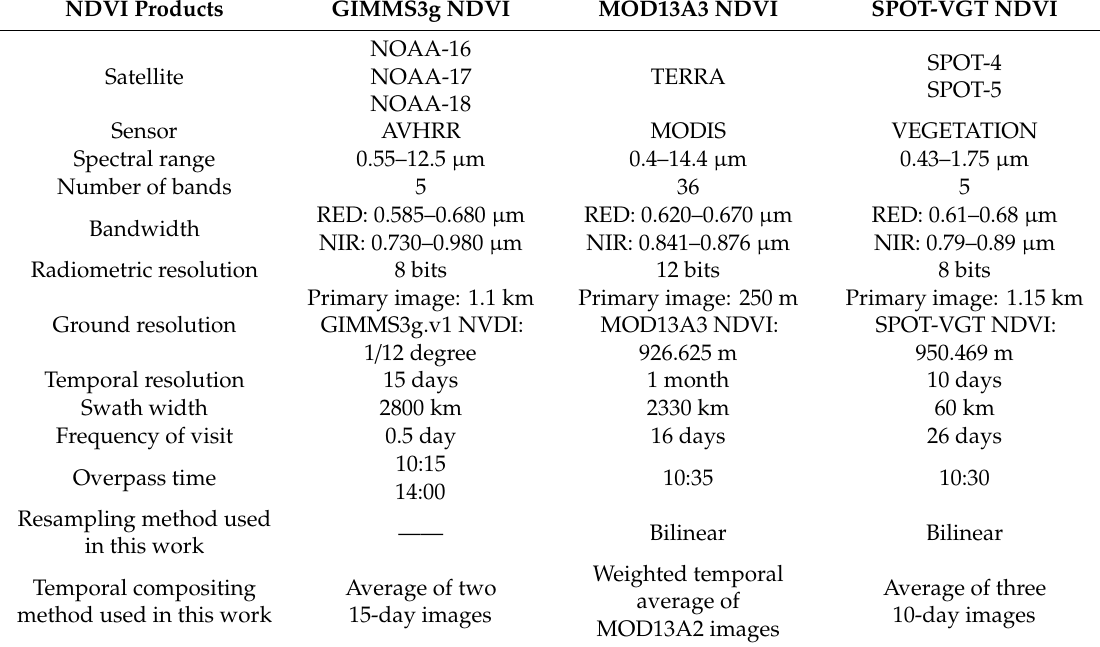
Table 1. Comparison of systematic parameters of three normalized di ff erence vegetation index (NDVI) products. NDVI Products GIMMS3g NDVI MOD13A3